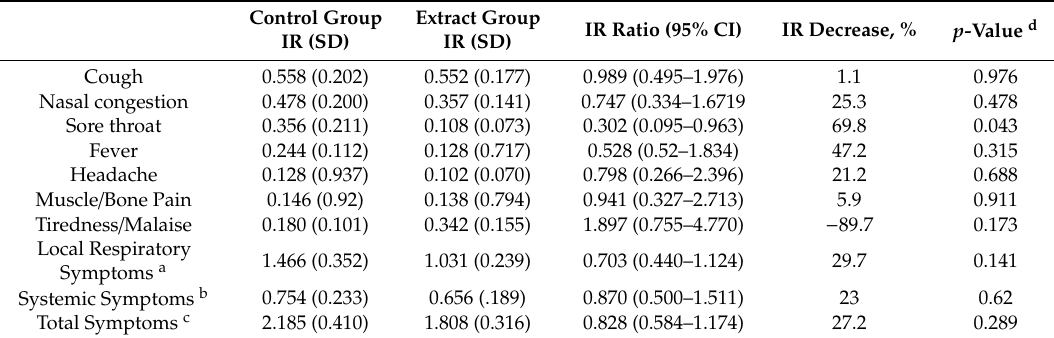
Table 3. Incidence of symptoms related to respiratory infections.